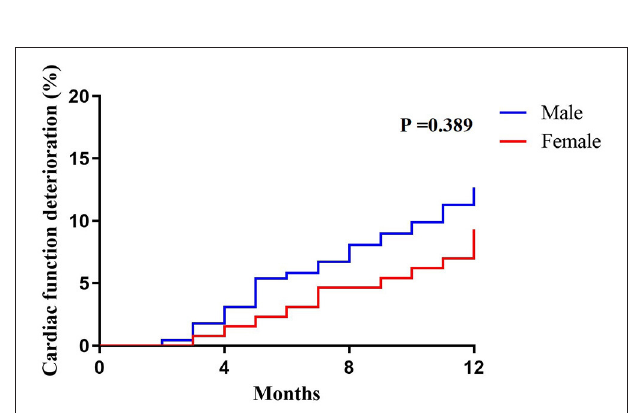
FIGURE 3 | Cardiac function deterioration events between different sex in follow-up.